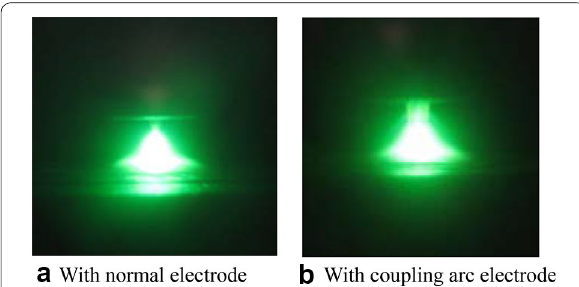
Figure 8 Comparison of arc shapes with normal electrode and coupling arc electrode